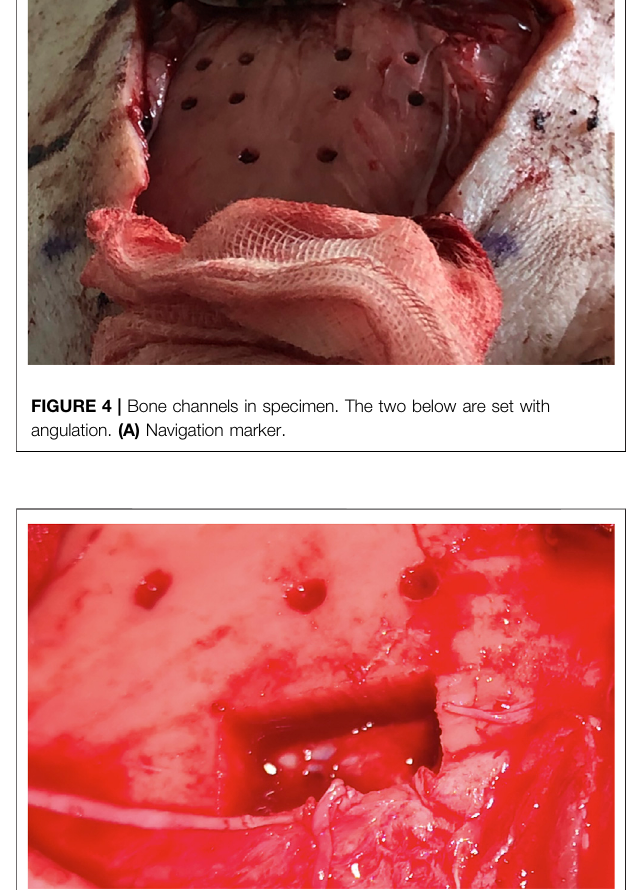
FIGURE 5 | Ad-hoc planned rectangle-shaped craniotomy to evaluate dural